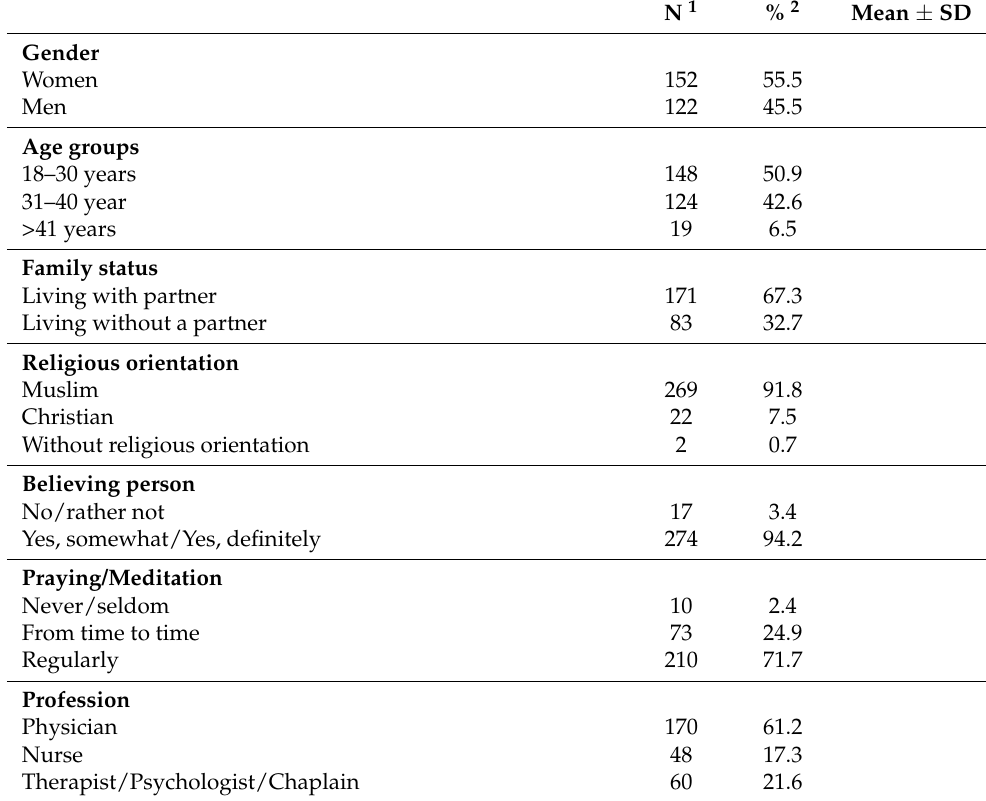
Table 1. Description of 294 participants from